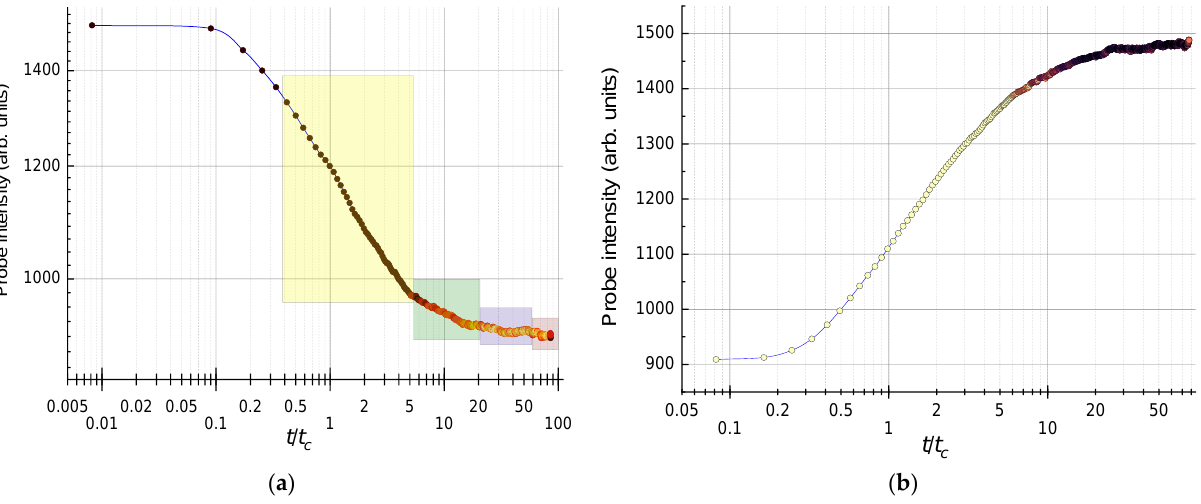
Figure 14. Transient ( a ) development and ( b ) dissipation curves (data are not filtered out) of a single heating – cooling cycle in a thermal-lens experiment (ferroin, water); the time axis is normalized to the characteristic time 𝑡 𝑐 , Equation (5); for the cooling curve, the starting point of the dissipation is set to zero. Setup, TLS-60; excitation wavelength, 532.0 nm; excitation power, 40 mW.